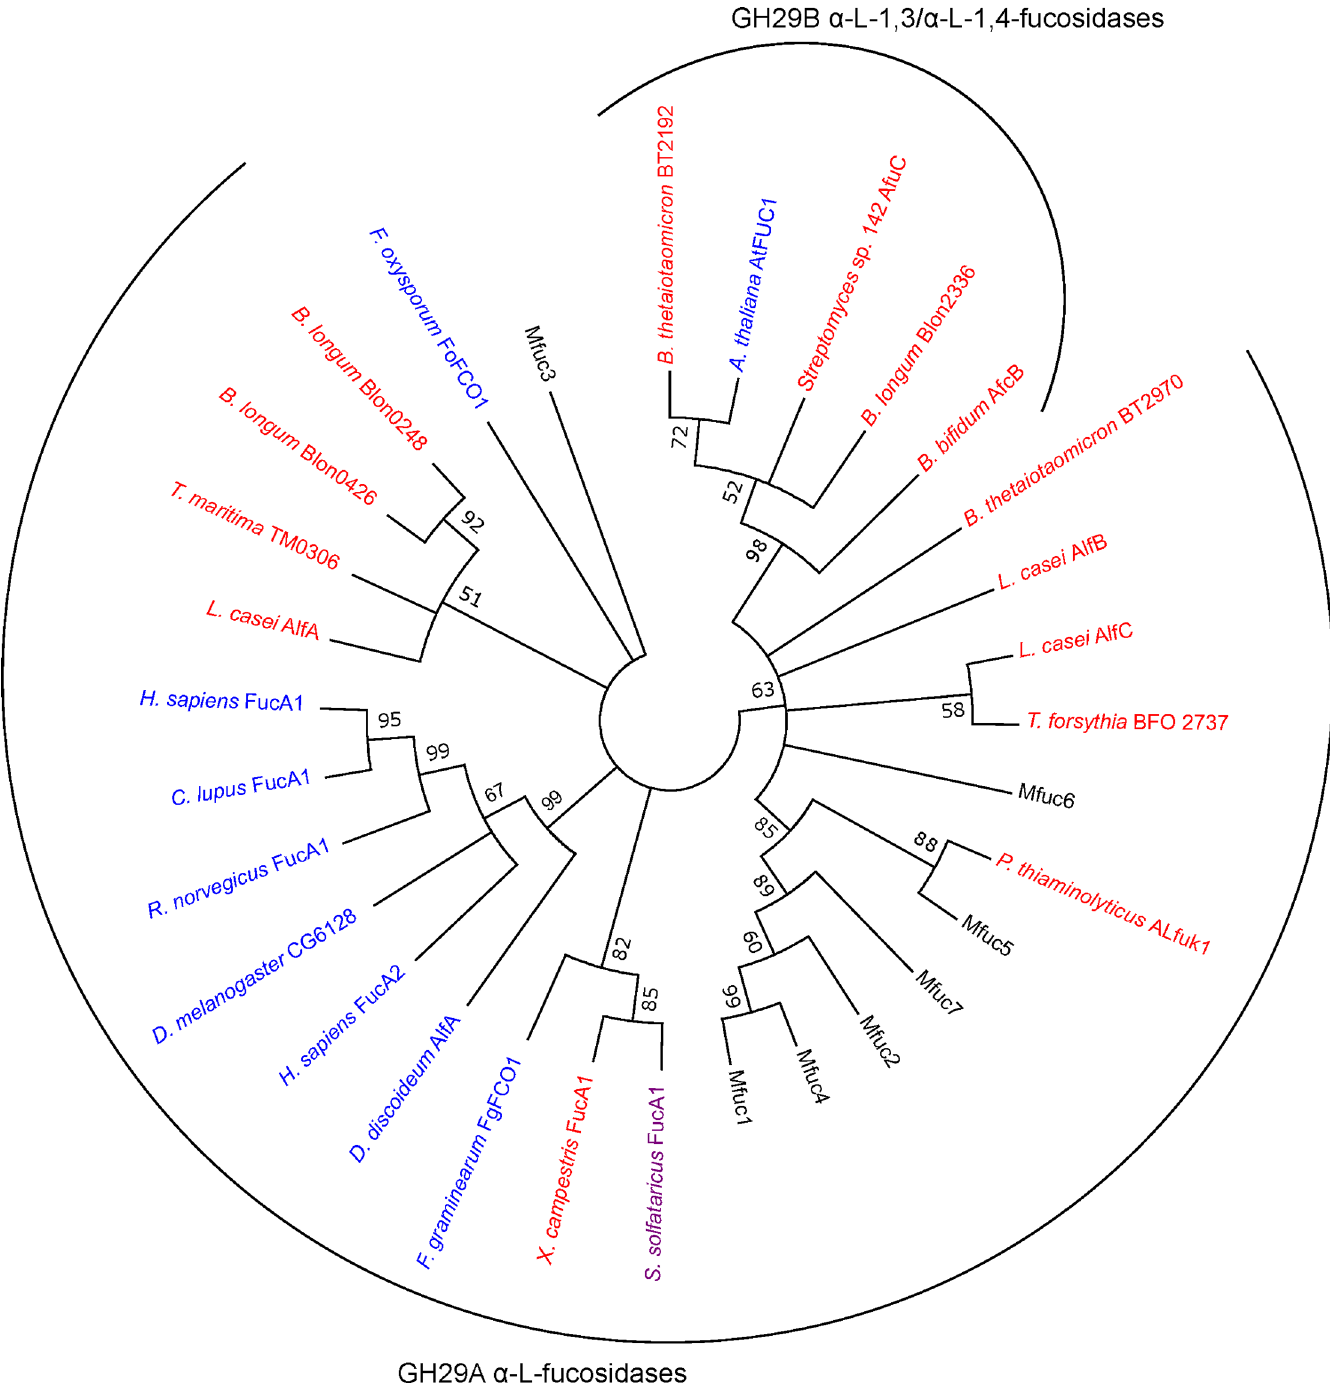
Fig 1. Phylogenetic tree of novel α -L-fucosidase sequences, Thma and characterised representatives of GH 29 family. Phylogeny was inferred using the neighbour-joining method. The percentage of replicate trees ( > 50%) in which the associated taxa clustered together in the bootstrap test (500 replicates) are shown next to the branches. Bacterial α -L-fucosidases are shown in red, eukaryotic in blue and the archeal α -L-fucosidase in purple. Accession numbers for the enzymes included in the analysis are provided in the materials and methods